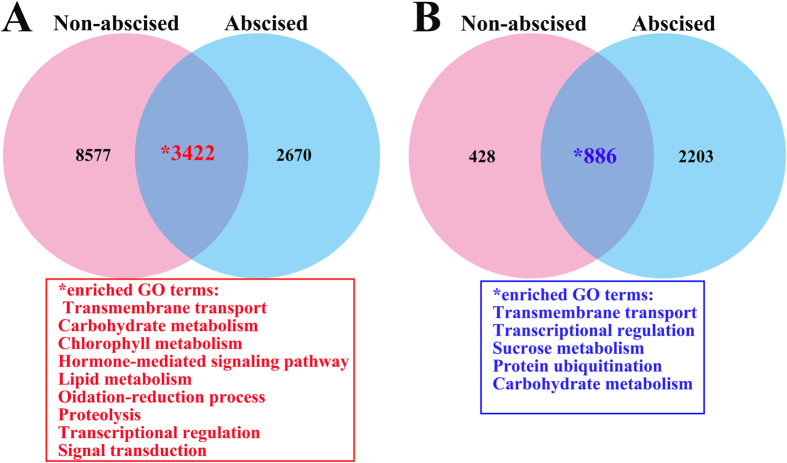
Comparative analysis of ethephon-responsive genes in non-abscised and abscised SDM shoots.(A and B) Number of unigenes up-regulated (A) and down-regulated (B) in non-abscised and abscised SDM shoot at 3 day after ETH treatment, respectively. The enriched GO terms were represented by asterisk.